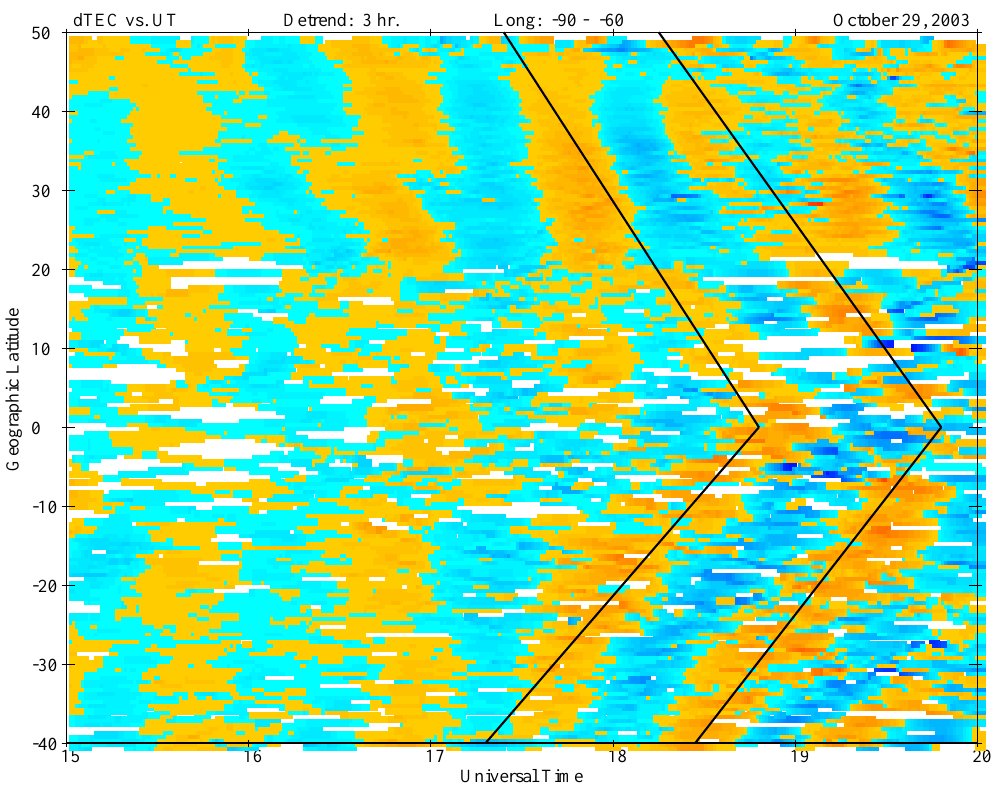
Fig. 4. Color-coded representation of the TEC perturbations in a reference frame of geographic latitude versus universal time. Each pixel indicated here corresponds to the average of the perturbations that were observed in longitude between 90 ◦ W and 60 ◦ W at the latitude and time indicated in the figure.